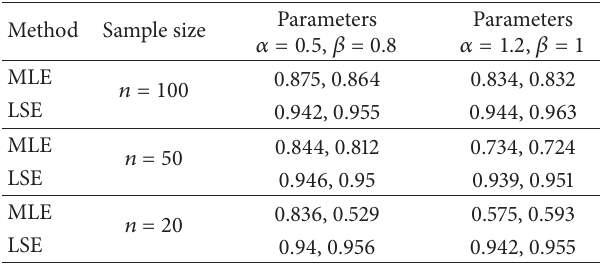
Table 3: Coverage probabilities for the parameters based on estima- tion methods. Method Sample